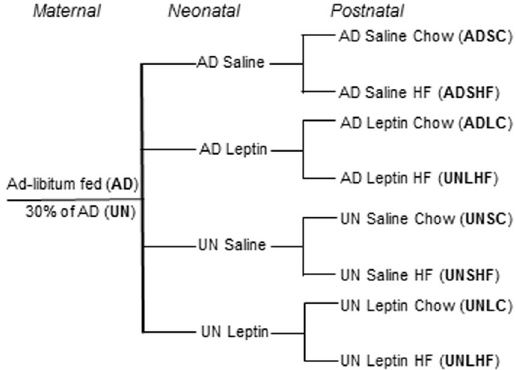
Figure 1. Schematic of the experimental design, in which rats (n = 8/group) were exposed to combinations of programming (UN = undernutrition vs AD = ad libitum feeding during pregnancy), Leptin vs Saline administration on neonatal days 3–13, and High Fat (HF) vs Chow (C) post-weaning